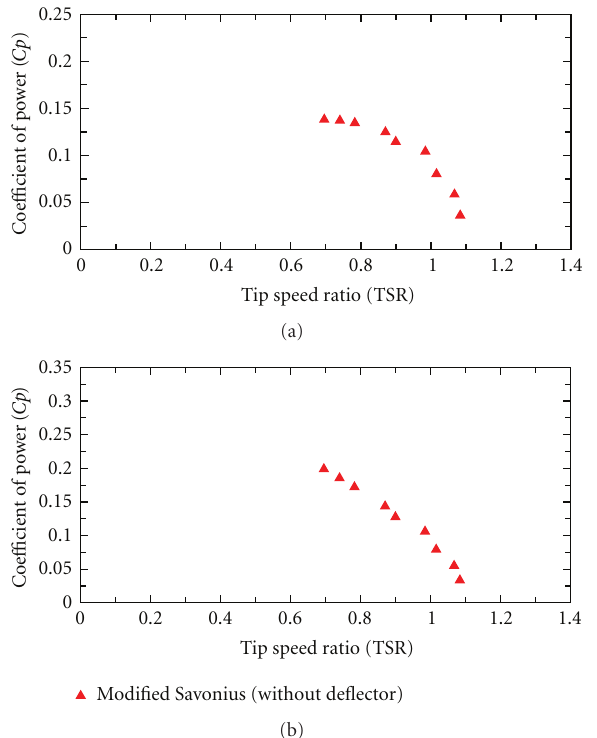
Figure 10: Variation of coe ffi cient of power and coe ffi cient of torque with respect to tip speed ratio for modified Savonius without deflector.